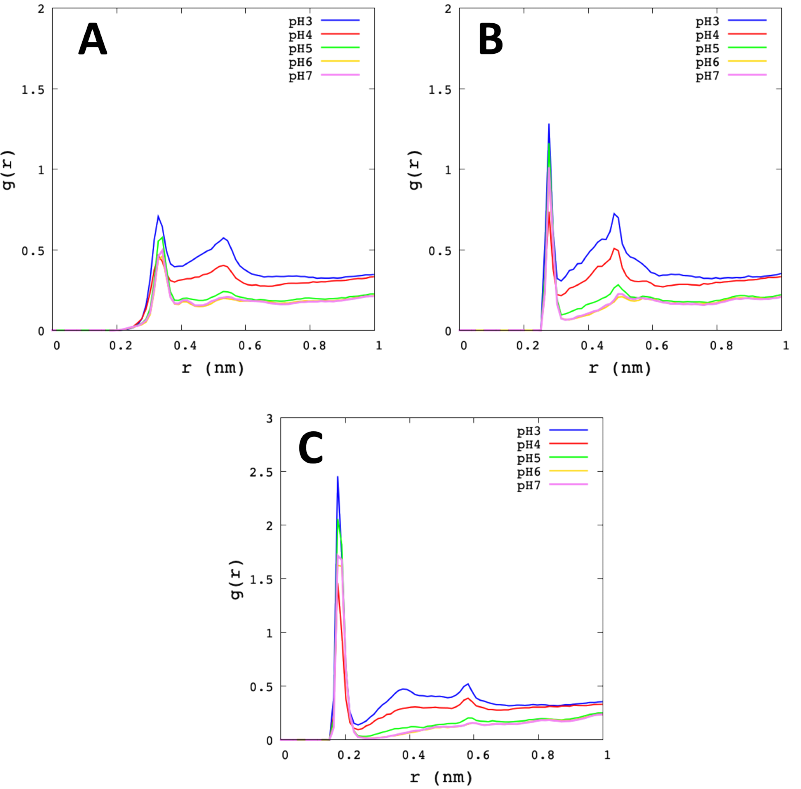
Figure 8. Radial distribution function of His41. The graphs show the average value of the Mpro protomers and the different microstates for each pH. ( A ) N δ 1–H ω . ( B ) N δ 1–O ω . ( C ) H δ 1–O ω .